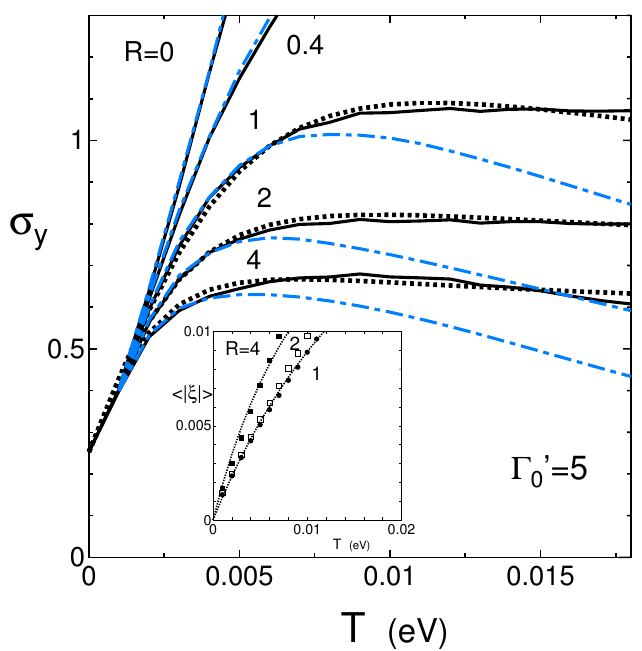
= 5 for R = 0, 0.4, 1, 2, and 4 (solid line). The dot Figure 4. (Color online) T dependence of σ y with Γ (cid:48) 0 line denotes a fitting one obtained from Equation (17). The dot-dashed line denotes σ y obtained for the fixed µ = µ ( 0 ) , where the deviation from the solid line starts at lower T for the larger R . The inset denotes T dependence of < | ξ | > obtained from Equation (19) with a fitted line for R = 0.5, 1, and